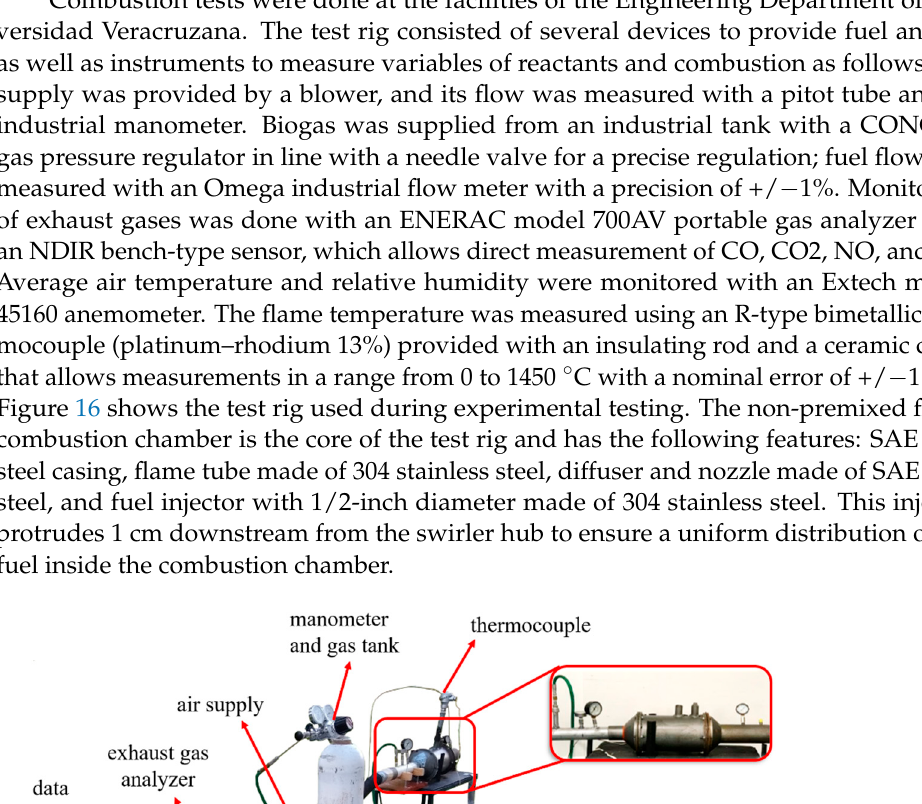
Figure 15. Mole fraction variation of NO at the outlet of the combustion chamber on the y -axis.